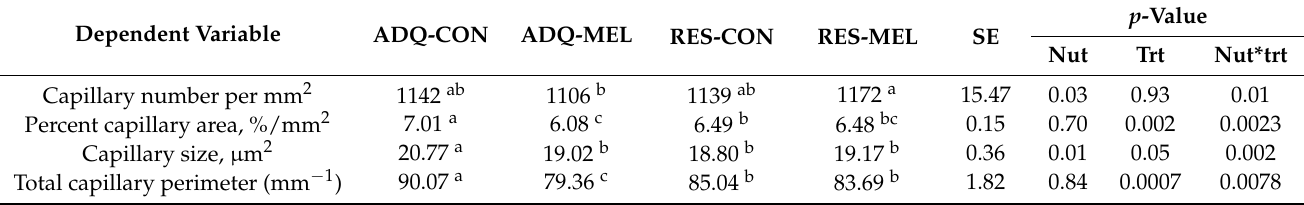
Table 2. Histological analysis for capillary characteristics of 8-month-old fetuses. Different letter superscripts (a–c) represent significant differences ( p < 0.05) between the nutritional plane and treatment